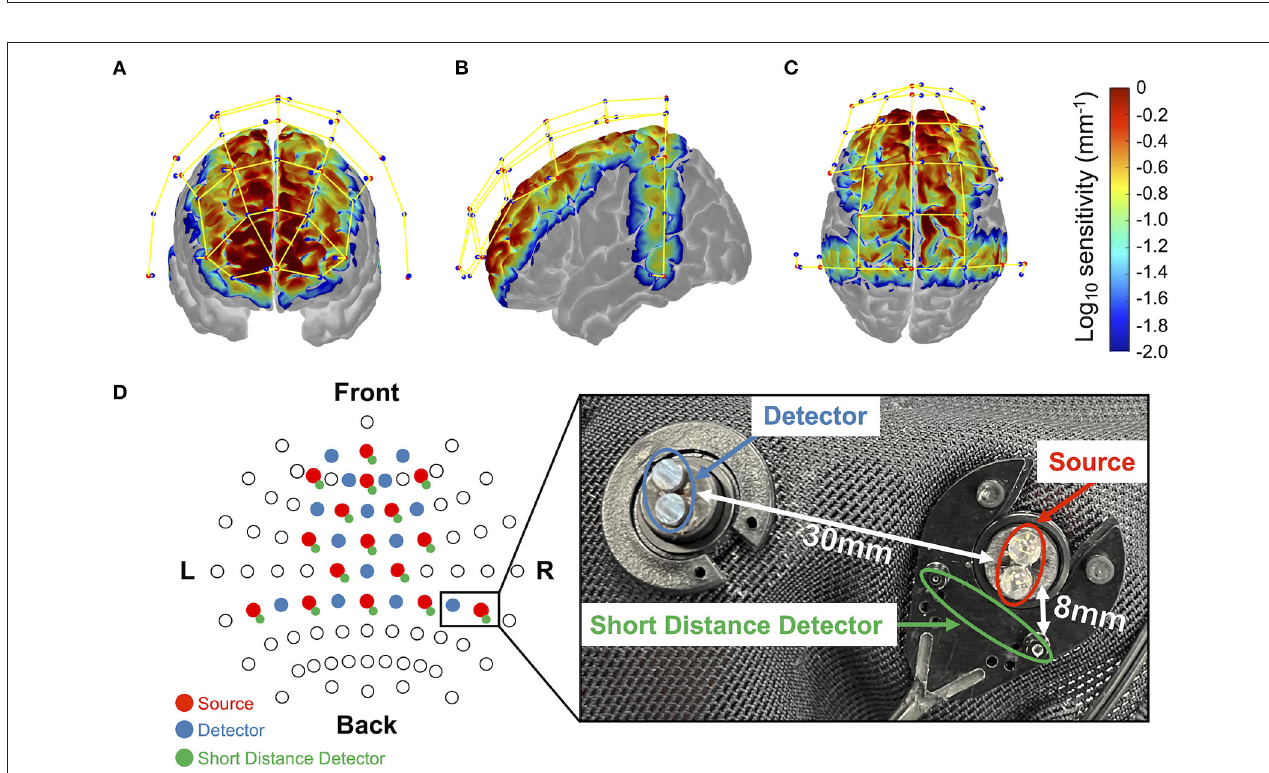
FIGURE 2 | Monte-Carlo simulation results over frontal cortex (A) , temporal cortex (B) , and parietal cortex (C) . Red dots represent emitters, blue dots represent detectors, and yellow lines represent measurement channels, respectively (created using Homer 2 AtlasViewer; v2.8, p2.1: https://www.nitrc.org/frs/shownotes.php? release_id=3956). The color bar represents the spatial sensitivity of fNIRS measurements. The two-dimensional fNIRS montage using the International 10–20 measurement system as reference is presented in (D) . Blue circles represent the short-range photosensitive area. The sensitivity value has mm − 1 units and is displayed in log 10 units. It yields the estimated value of optical density change by multiplying the sensitivity value by the absorption change in the measurement channel (in mm − 1 ) and the area where the change occurred (in mm 2 ).